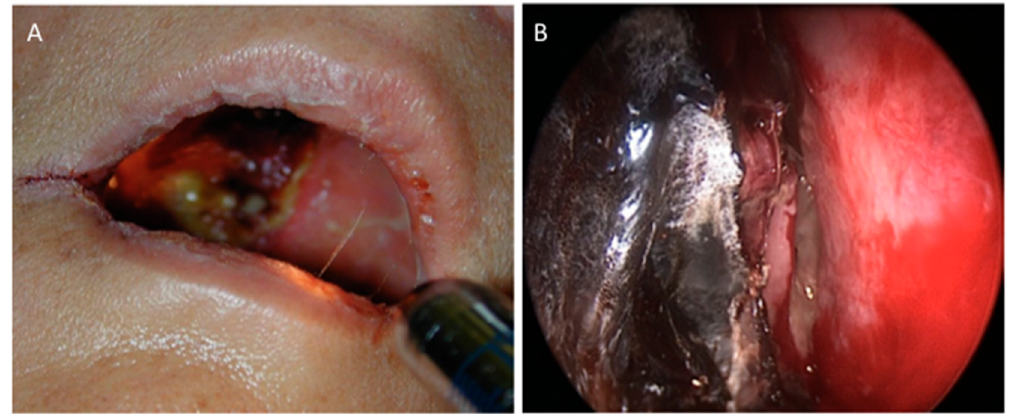
Figure 1. Necrosis in rhino-orbito-cerebral mycormycosis. ( A ): ROC Mucormycosis with palatal involvement and necrosis. ( B ): Endoscopic examination shows necrosis of the middle right meatus. Used with kind permission from B. Verillaud, personal data.